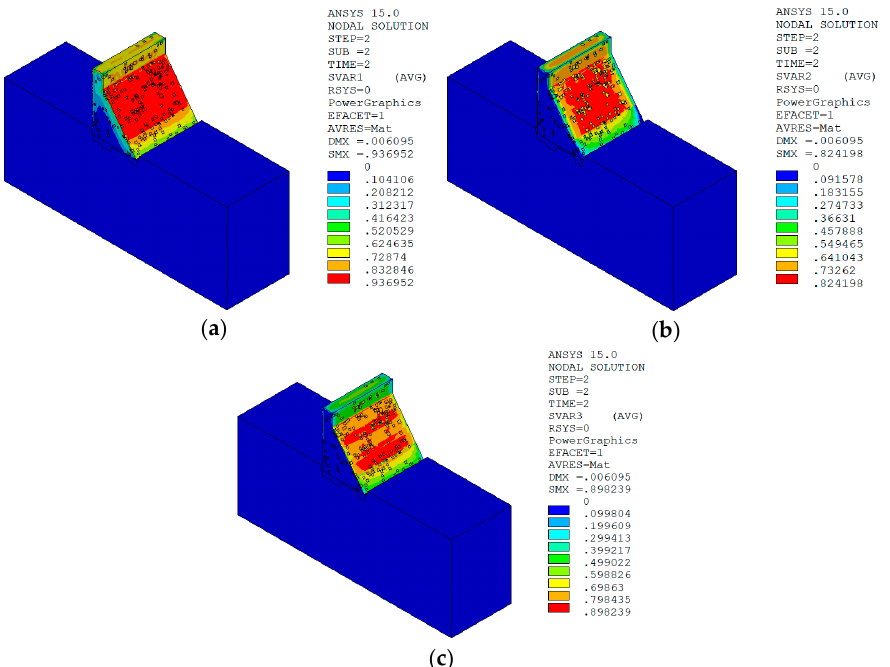
Figure 13. The temperature damage distribution of the dam body in the three principal strain directions is calculated by the macro-meso model under the temperature drop condition, ( a ) The temperature damage distribution in the first principal strain direction, ( b ) The temperature damage distribution in the second principal strain direction, ( c ) The temperature damage distribution in the third principal strain direction.